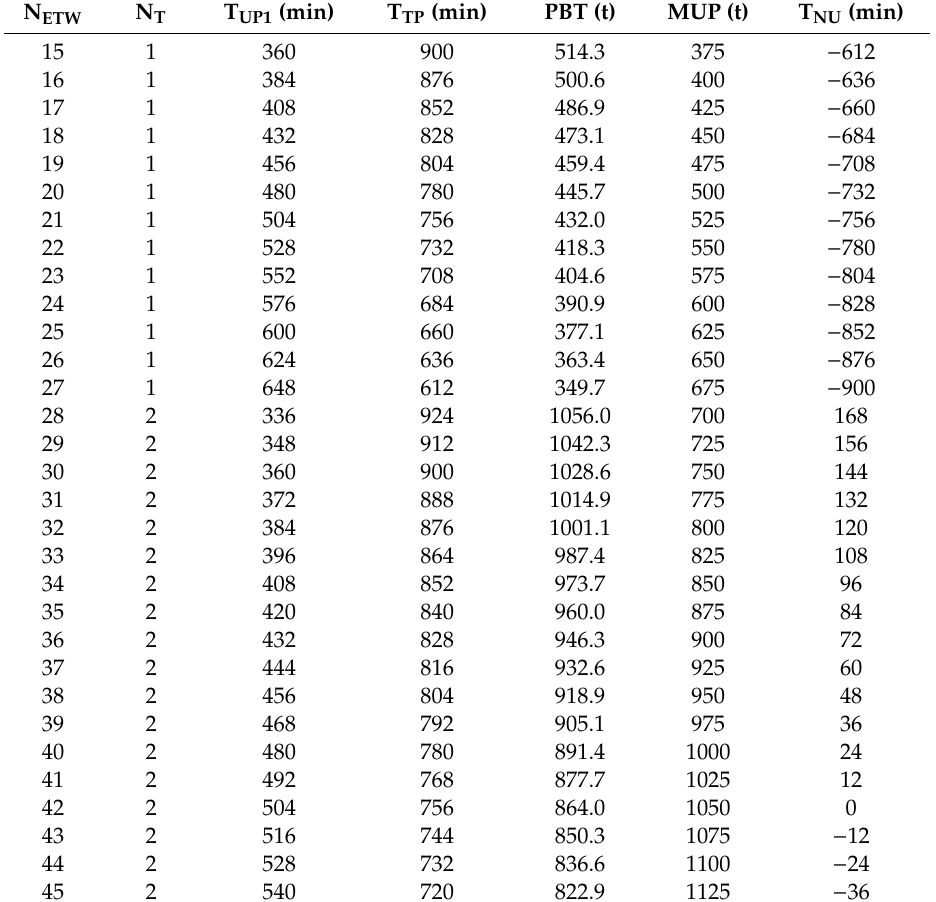
Table 4. Results for E = 1 and daily biomass amount required for the production line (Q) = 854